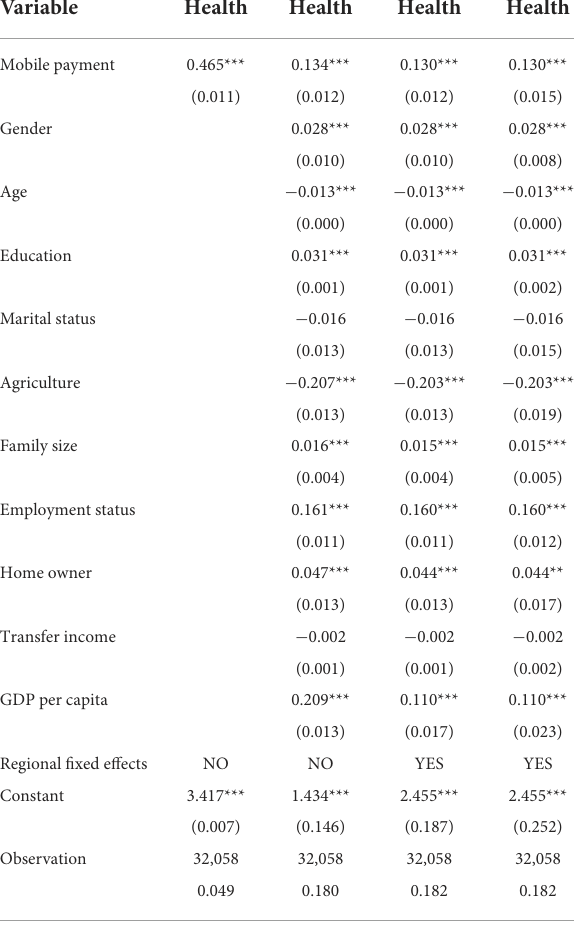
TABLE 4 The impact of mobile payment on physical health—accounting for